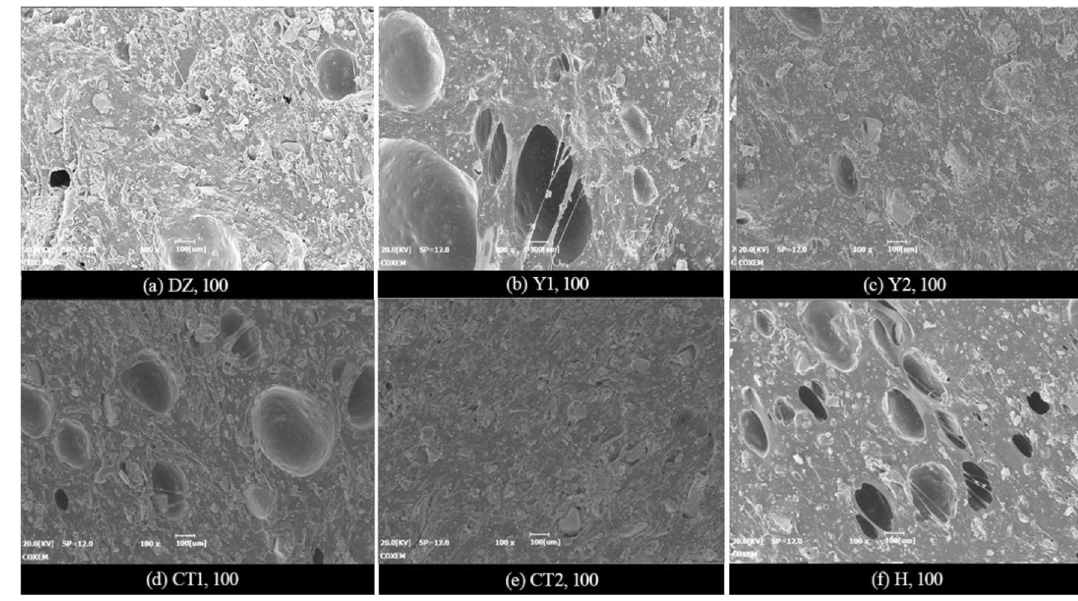
Figure 10. Microscopic pore observation.